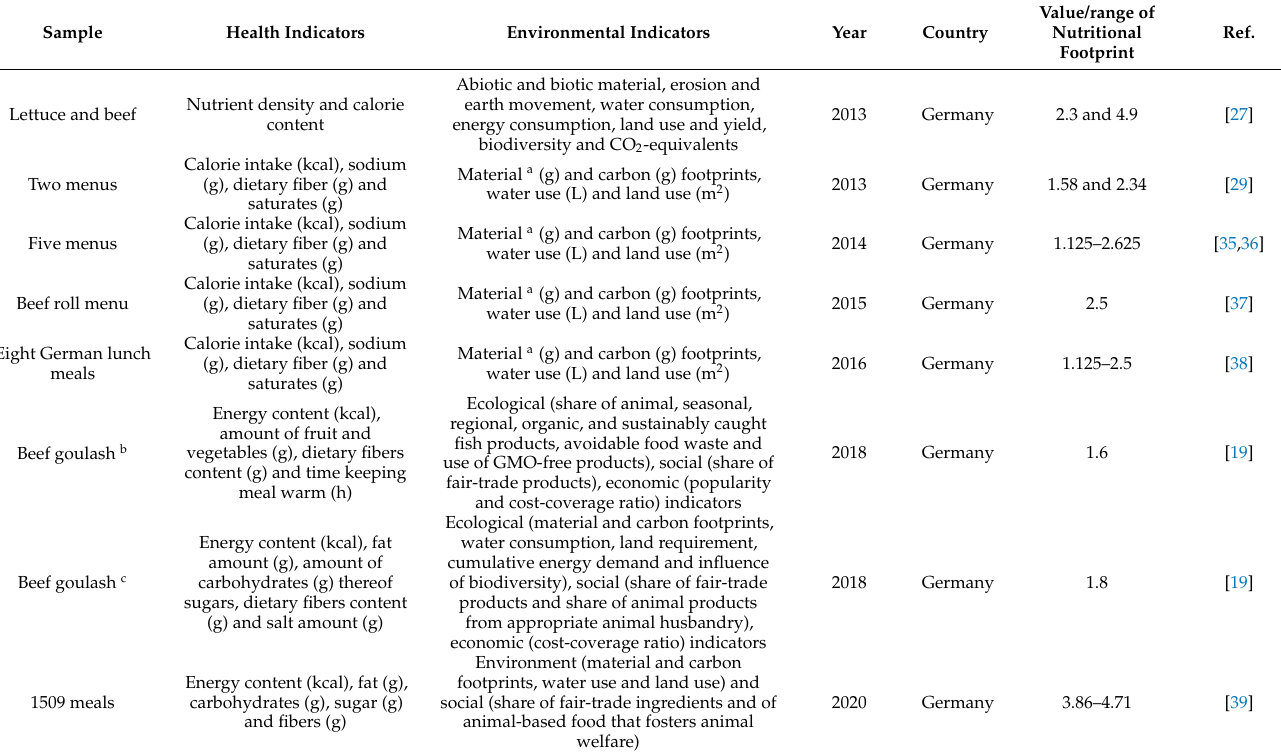
Table 1. Some values/ranges of the nutritional footprint of different foods, menus, and